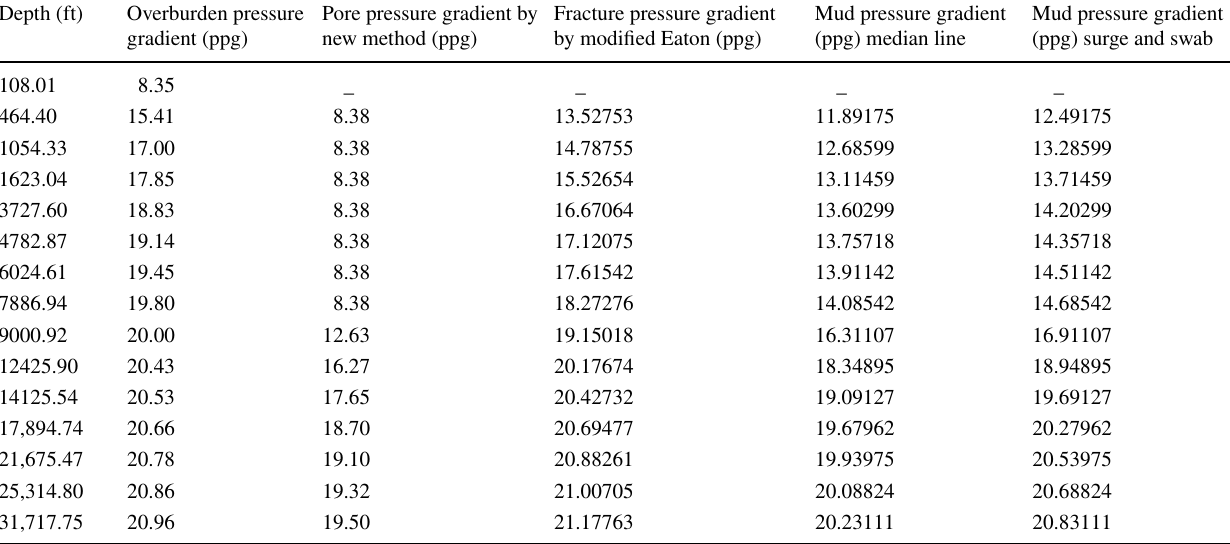
Table 4 Optimum mud weight by median line principle on the top of the Tulamura anticline Depth (ft) Overburden pressure Pore pressure gradient by Fracture pressure gradient gradient (ppg) new method (ppg) by modified Eaton (ppg)